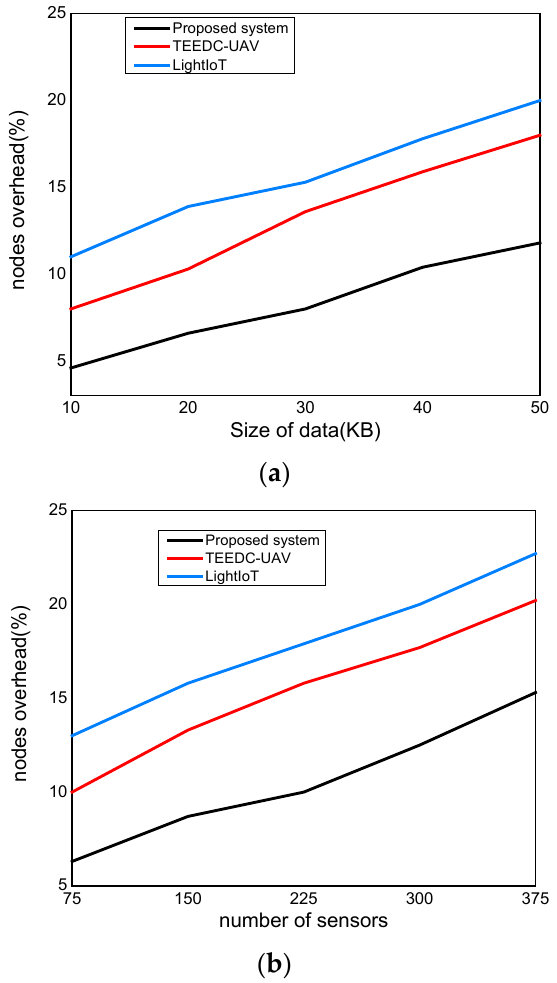
Figure 7. Performance results for varying data sizes and sensors for nodes overhead. ( a ) Nodes overhead with varying data size; ( b ) nodes overhead with varying number of sensors.